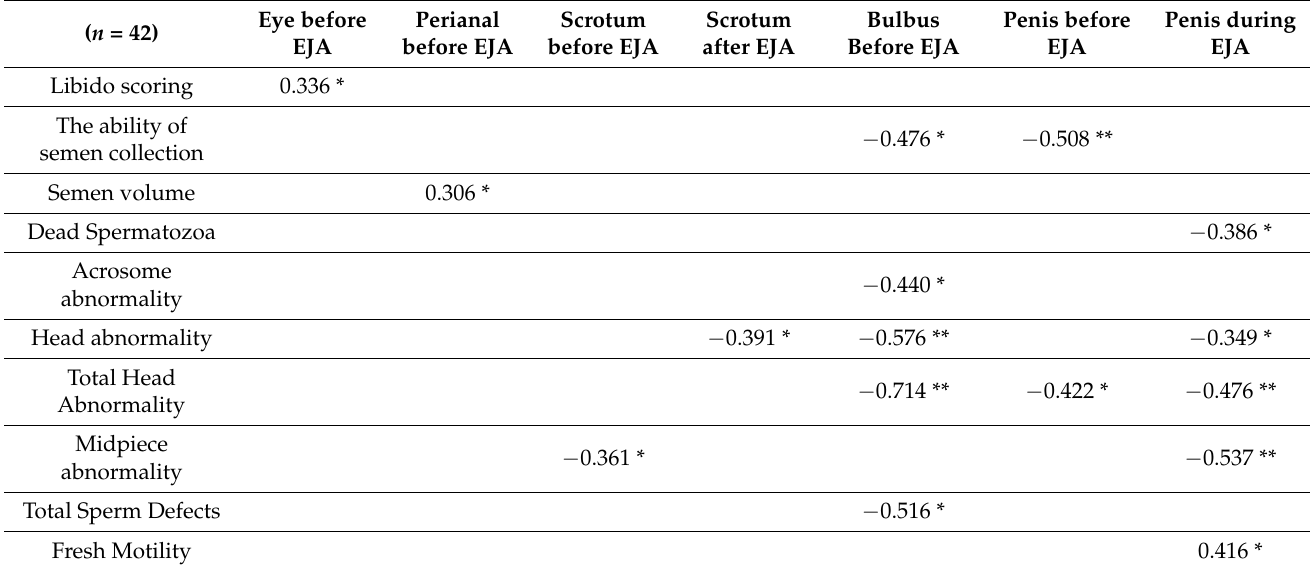
Table 5. The correlation indices among thermal parameters and semen